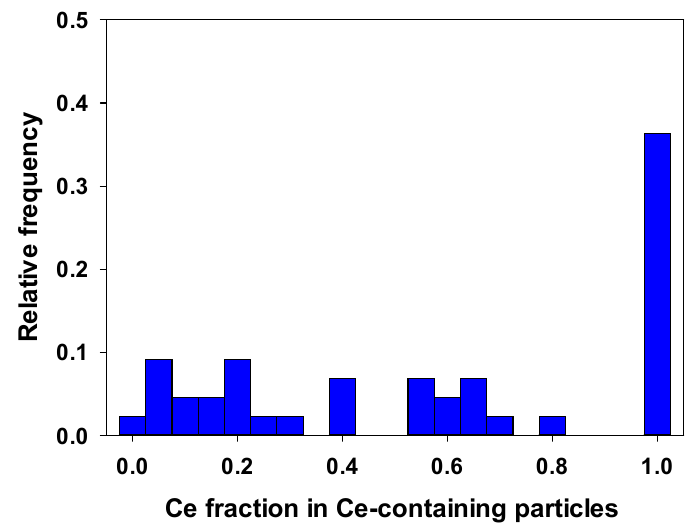
Figure 7. Detected proportion of Ce in Ce-containing particles measured in a Montreal rainwater. A Ce fraction of 1 indicates a pure Ce NP, while a fraction < 1 indicates the presence of other elements in the particles. Measurements were obtained using the TOF-ICP-MS with a 76.5 µs dwell time; SDL (Ce) = 11 nm and SQL (Ce) = 16 nm.